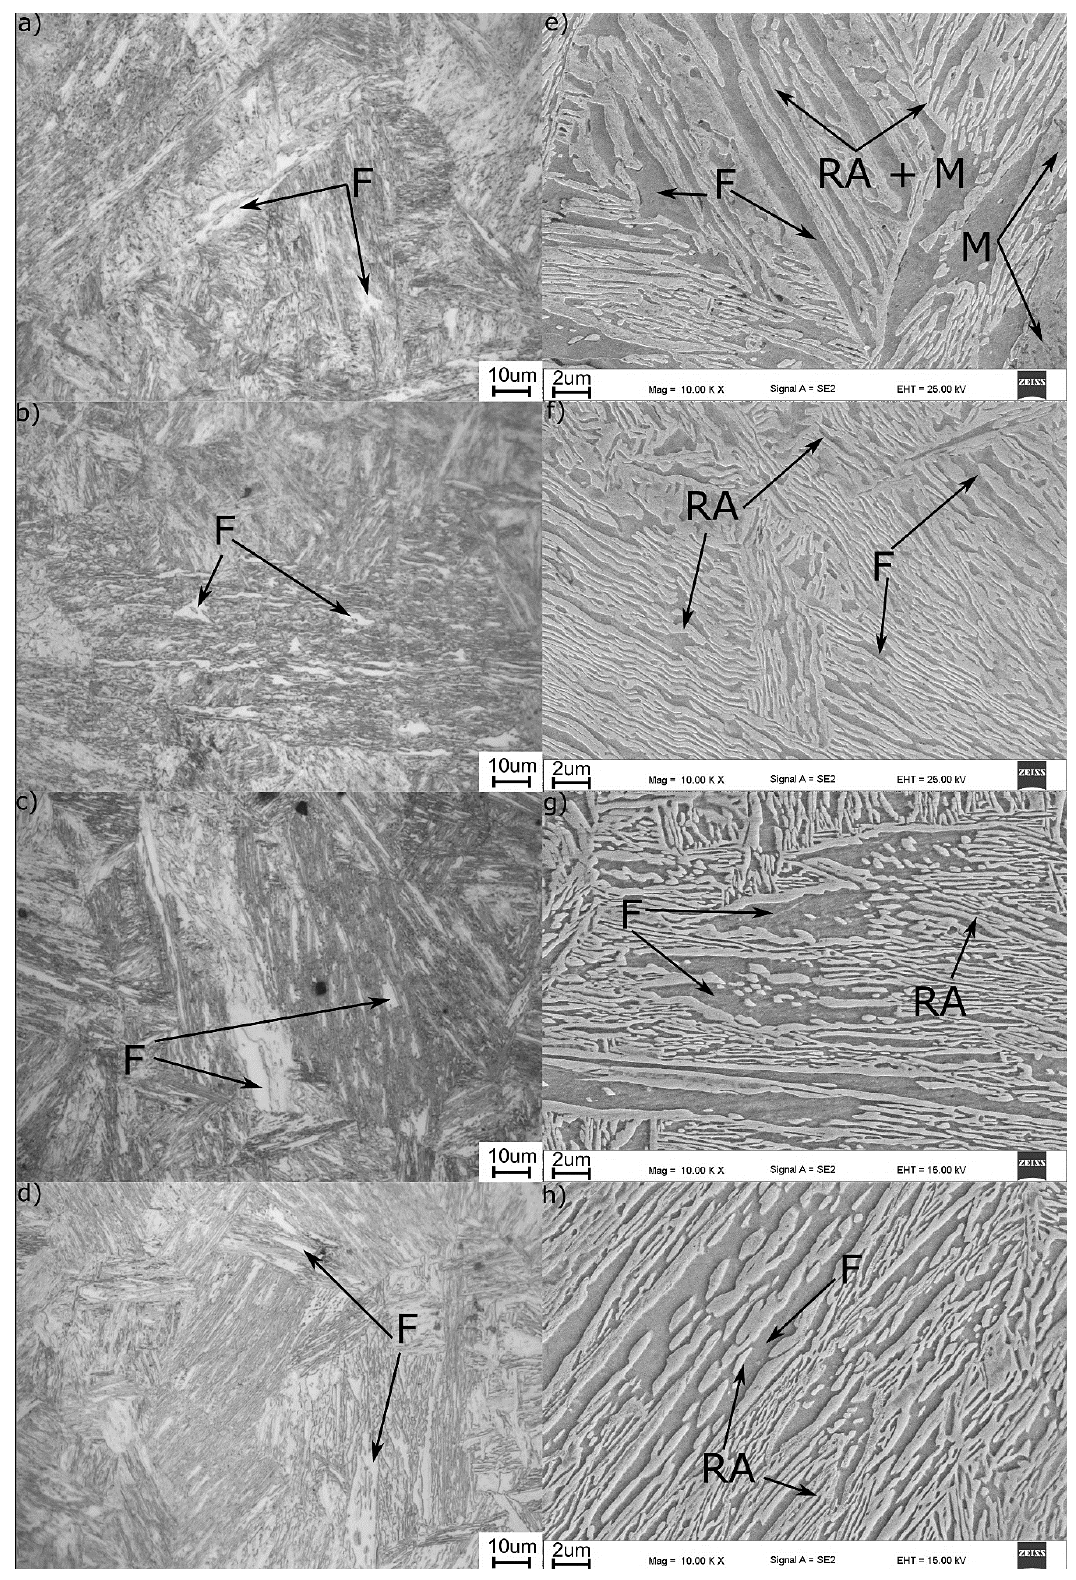
Figure 8. Light and scanning electron microscopy microstructures of intercritically annealed steel ( a – e ) 720 ◦ C, ( b – f ) 700 ◦ C, 1 h, ( c – g ) 700 ◦ C, 2 h, ( d – h ) 700 ◦ C, 5 h. F—ferrite, M—martensite, RA—retained